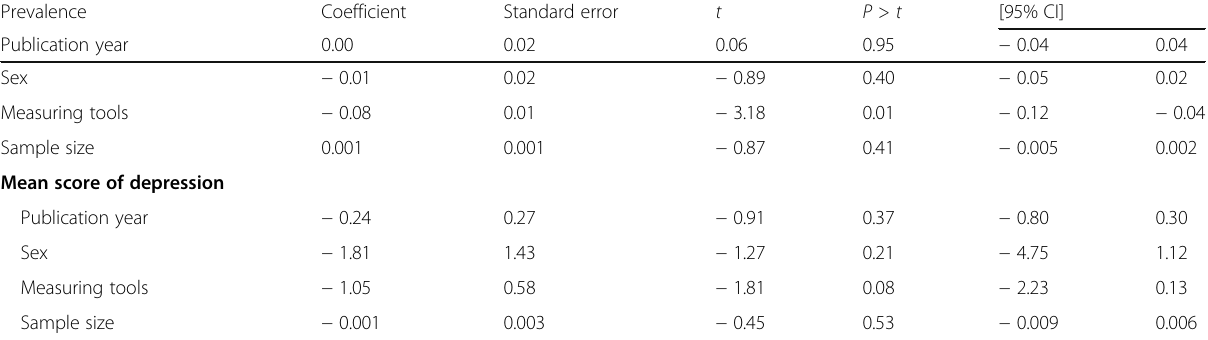
Table 5 The result of meta-regression on the heterogeneity of pooled estimations